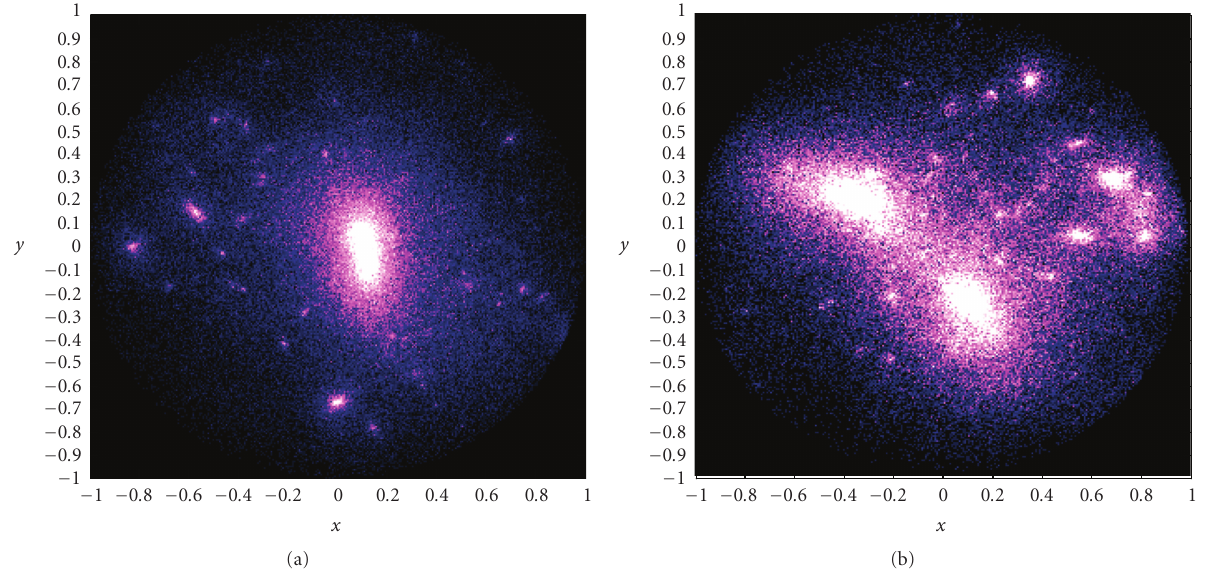
Figure 5: Two cluster halos extracted from an n -body simulation at z = 0. One is isolated and relaxed (a), while the other is in the process of forming through a major merger (b). In each case, only particles within 1 Mpc of the halo are plotted.